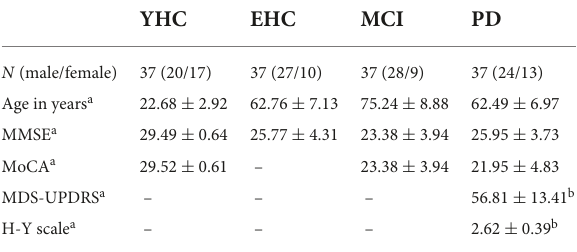
TABLE 1 Demographic and clinical characteristics of the human